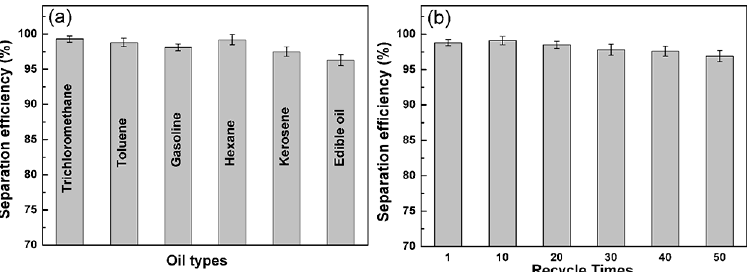
Figure 6. Oil separation efficiency of the superhydrophobic Cu 2 O mesh: ( a ) for various oil–water mixtures in the first cycle, ( b ) for toluene after different separation cycles.